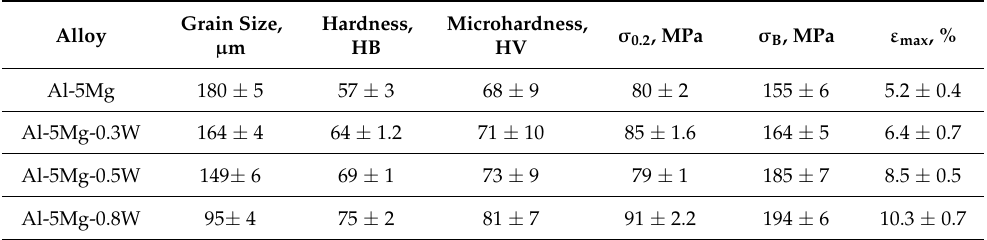
Table 2. Grain size, hardness, and tensile properties ( σ 0.2 —yield strength, σ B —ultimate tensile strength, ε max —ductility) of the aluminium alloys